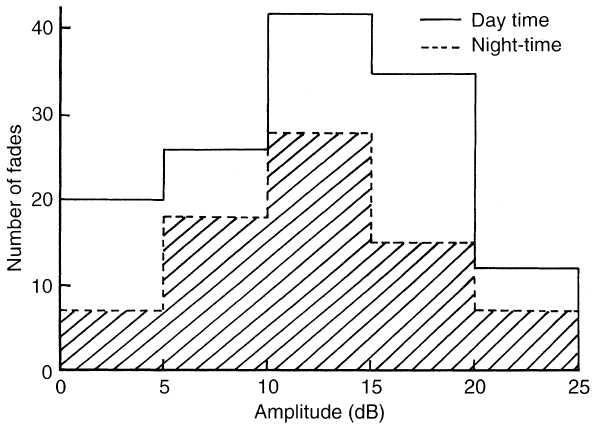
Fig. 4. Histograms showing the amplitude of fades for both daytime and night-time